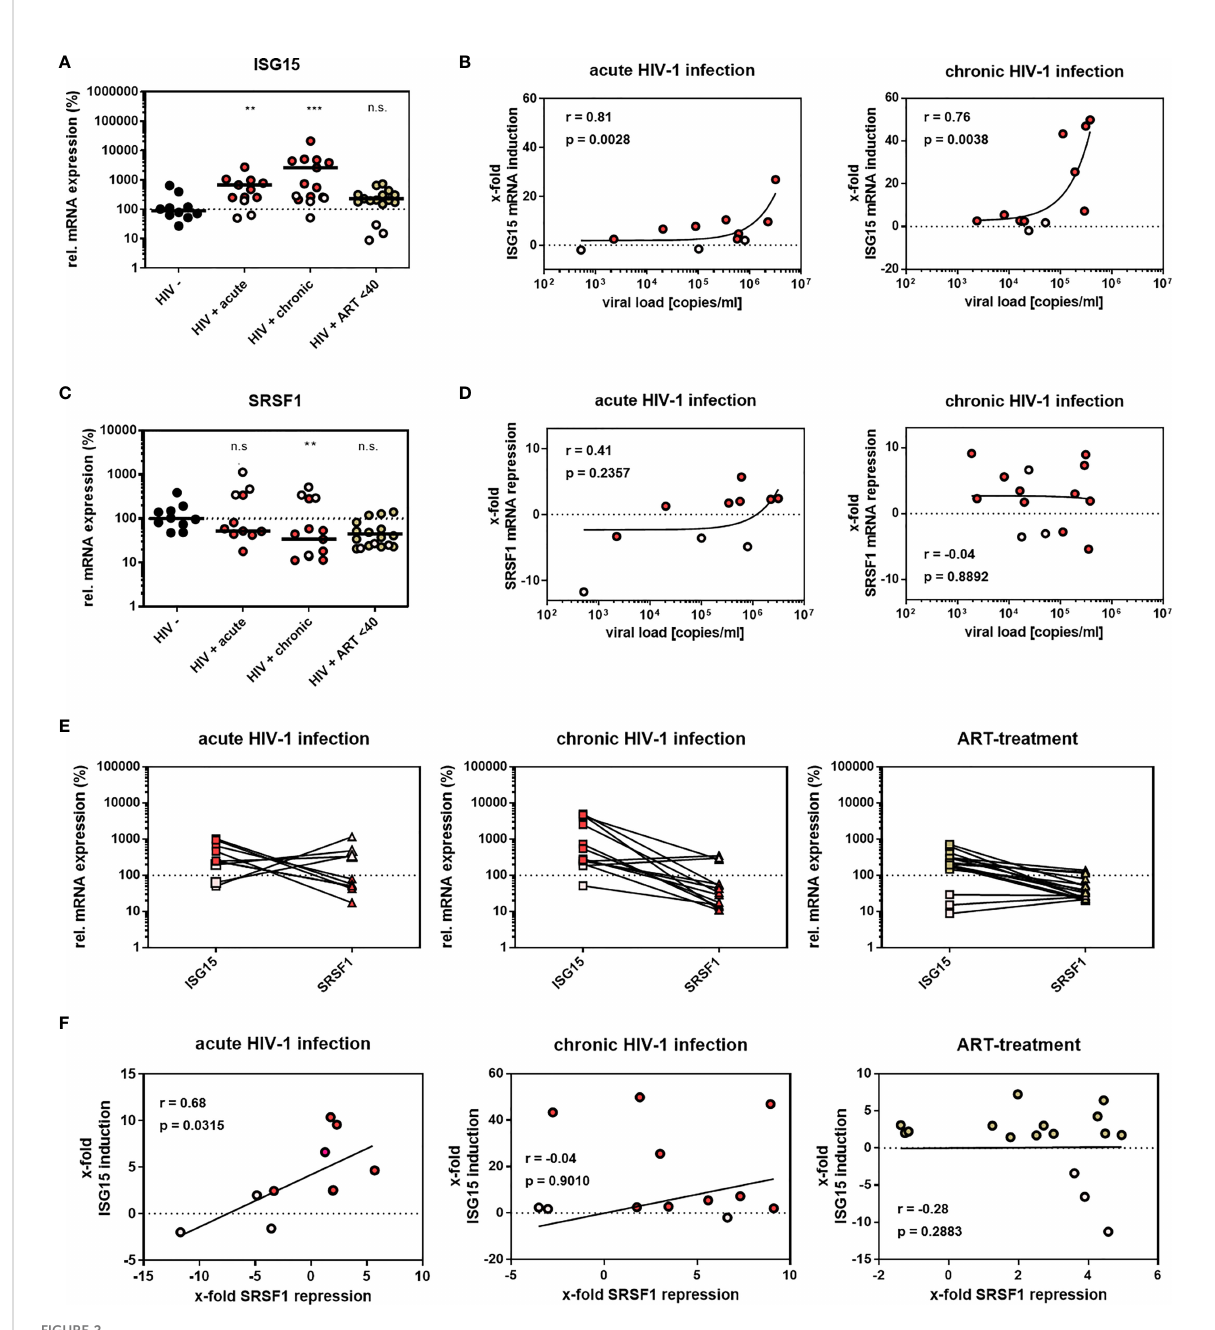
FIGURE 2 SRSF1 and ISG15 expression levels inversely correlate upon HIV-1 infection. (A, C) RT-qPCR determined the relative mRNA expression levels of (A) ISG15 and (C) SRSF1 in PBMCs from acutely and chronically HIV-1-infected patients, either naïve or under ART treatment as well as healthy donors. ACTB was used for normalization. Kruskal – Wallis test with the Dunn ’ s post-hoc multiple comparisons test was used to determine whether the difference between the group of samples reached the level of statistical signi fi cance (** p < 0.01, *** p < 0.001 and ns, not signi fi cant). (B, D) Correlation between plasma viral load of HIV-1-infected individuals and ISG15 and SRSF1 mRNA expression. RT-qPCR analysis was performed to determine ISG15 and SRSF1 mRNA expression. Pearson correlation was calculated between plasma viral load and (B) ISG15 or (D) SRSF1 expression for acutely and chronically HIV-1-infected patients. Pearson correlation coef fi cient ( r ) and p -value ( p ) are indicated. (E) Comparison of relative ISG15 and SRSF1 mRNA levels for individual patients. (F) Calculated correlation between x -fold repression of SRSF1 mRNA levels and x -fold induction of ISG15 mRNA levels for all patient groups. Pearson correlation coef fi cient ( r ) and p -value ( p ) are indicated. Data points from healthy donors were depicted in black, while data points from treatment-naïve HIV-1-infected individuals were shown in red. ART-treated patients are colored in green. Patients with no or low ISG15 mRNA induction upon HIV-1 infection were considered as low responders without IFN signature and were thus excluded from statistical analysis (light gray). This patient cohort included 10 uninfected donors, 8 acutely HIV-1-infected patients, 11 chronically HIV-1-infected patients, and 13 HIV-1-infected patients under ART